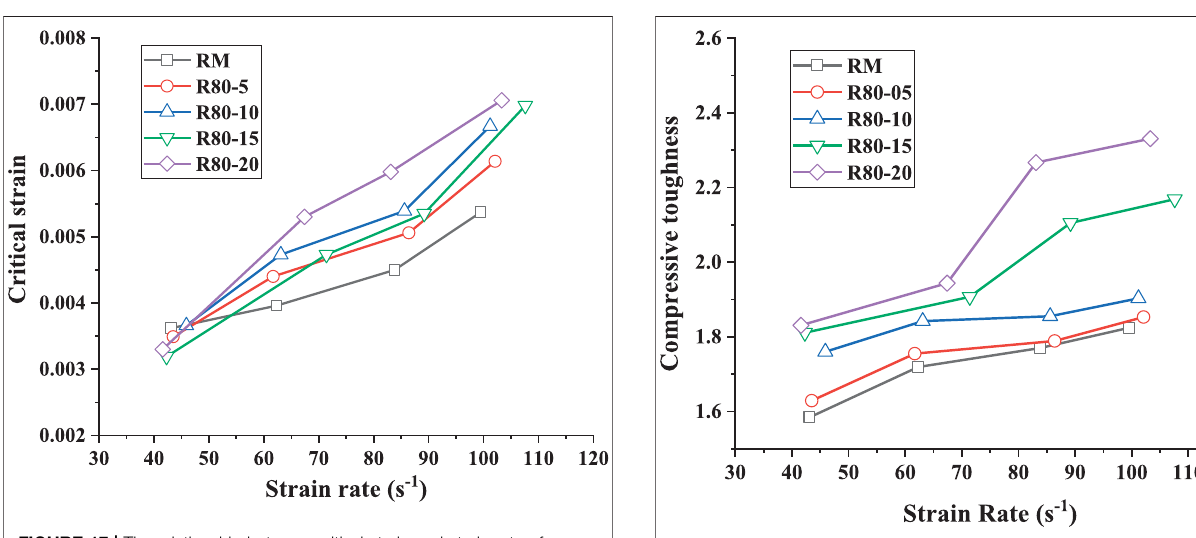
FIGURE 17 | The relationship between critical strain and strain rate of rubber mortar with different contents of crumb rubber.